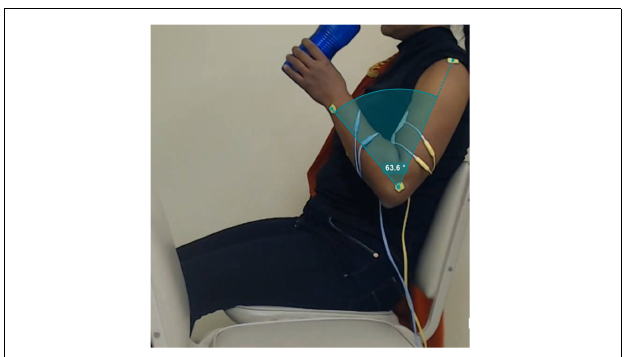
FIGURE 8 | Picture extracted from a frame of video recording of the “bottle to mouth” functional task. The green markers positioned in the shoulder, elbow and wrist joints are used in the Kinovea software to measure the elbow angle for each movement repetition, as illustrated in the green-shaded